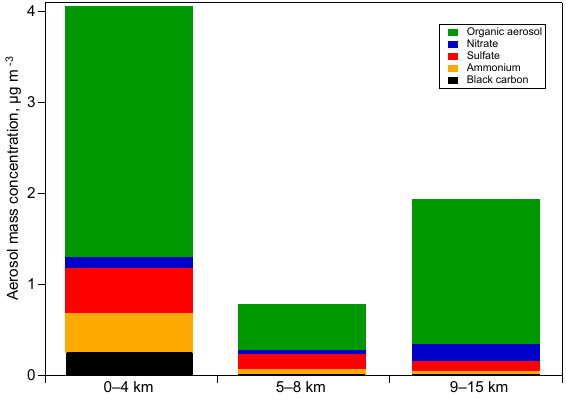
Figure 16. Aerosol chemical composition as determined by AMS and SP2 measurements in the lower, middle, and upper troposphere over